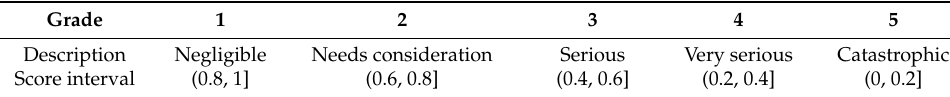
Table 3. Classification standard for engineering risk